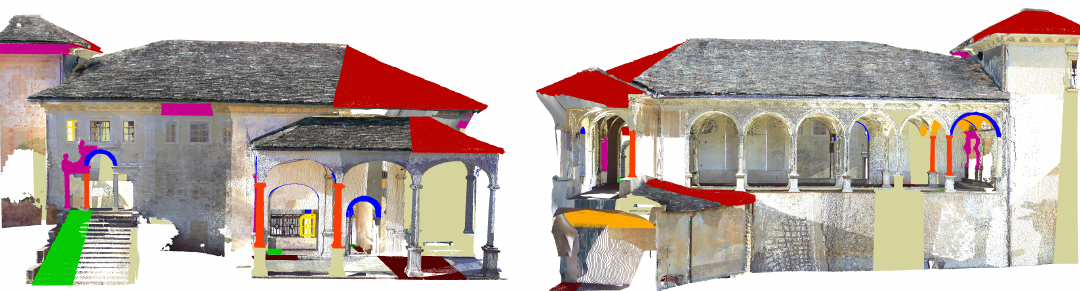
Figure 5. Manual annotations used to train the ML algortihms for the Sacro Monte Varallo (SMV)